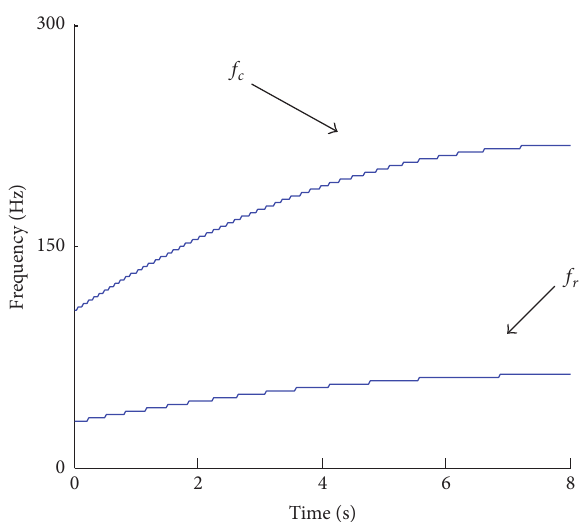
Figure 2: The waveform of the decay pulse signal.